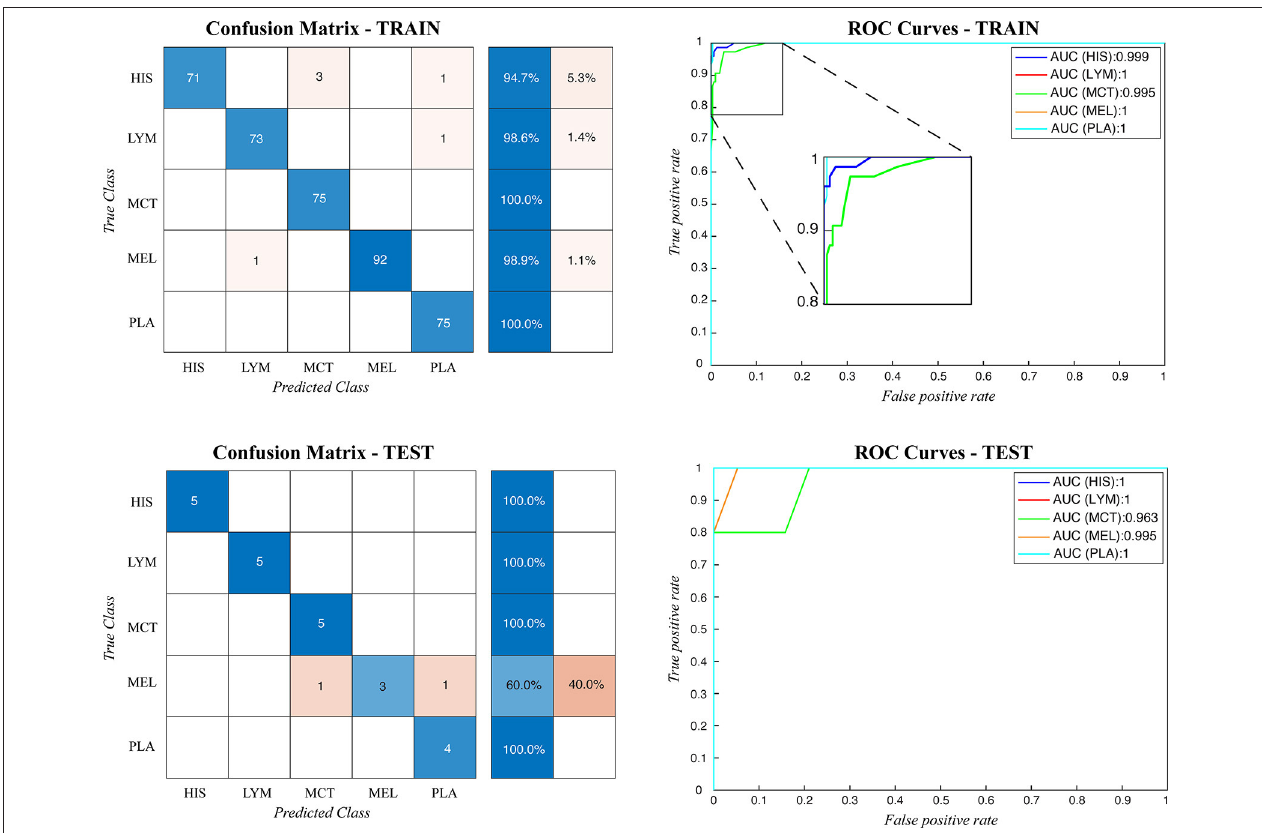
FIGURE 4 | Confusion matrix and the ROC curves obtained during CRCT classification for both train and test datasets. HIS, histiocytoma; LYM, lymphoma; MCT, mast cell tumor; MEL, melanoma; PLA,